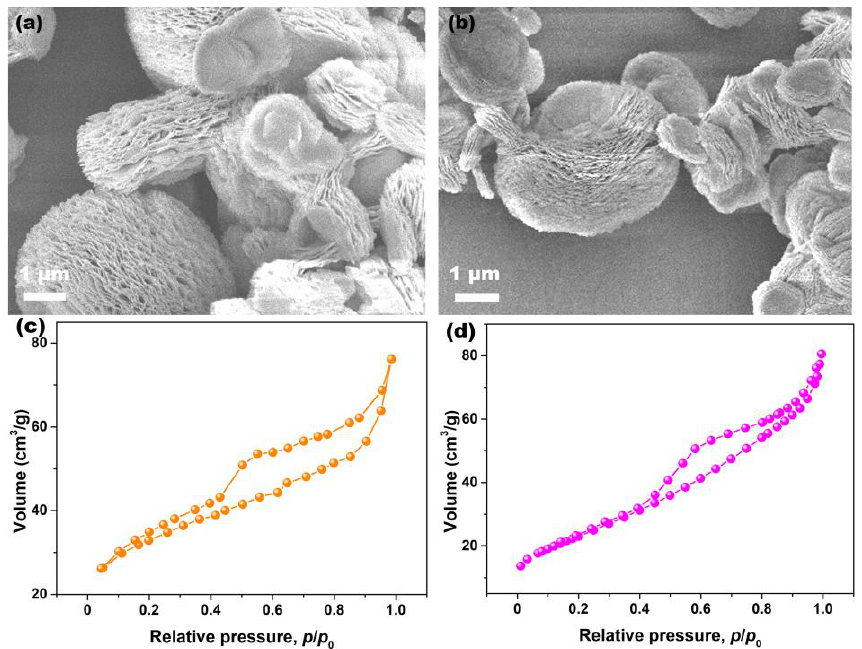
Figure 6. SEM images of ( a ) Undoped and ( b ) 6% Pr−doped CeO 2 , N 2 adsorption – desorption isotherms of ( c ) Undoped and ( d ) 6% Pr−doped CeO 2 .